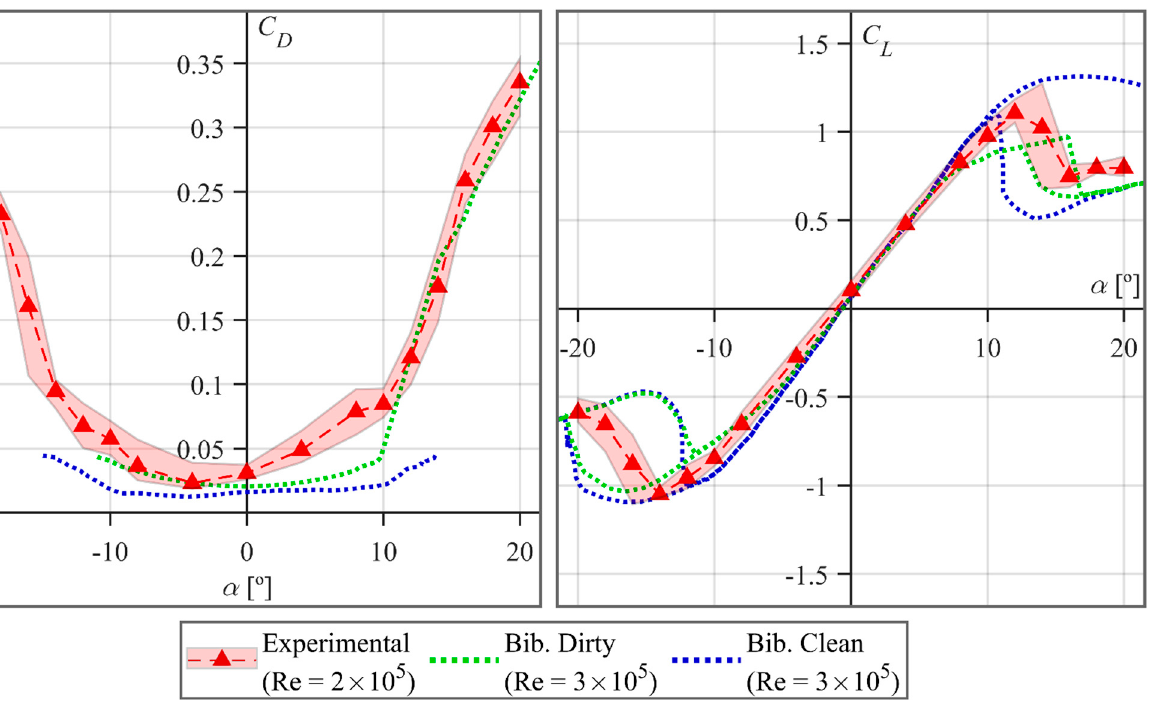
Figure 6. Experimental drag and lift coefficients from airfoil DU06-W-200 compared with data from the bibliography.